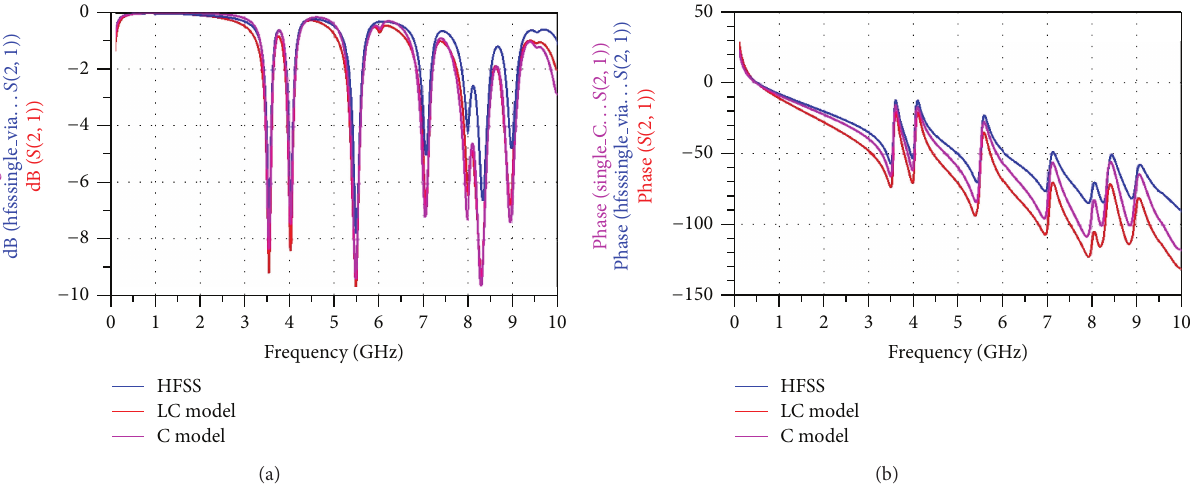
Figure 11: 𝑆 21 of a single via structure: (a) amplitude; (b) phase.